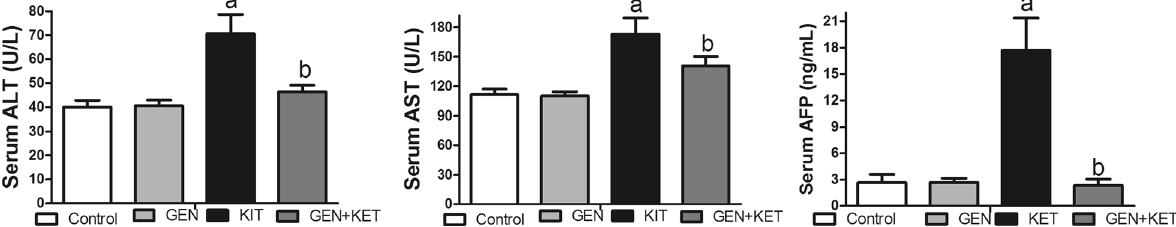
Fig. 1 Effect of GEN on serum aminotransferases activities (ALT and AST) and AFP concentration in control and KET-treated rats. Columns represent the means S.E.M for six animals in each group. Significance was determined by one-way analysis of variance followed by Dunnett’s t test: a P < 0.05 ± versus control group; b P < 0.05 versus KET